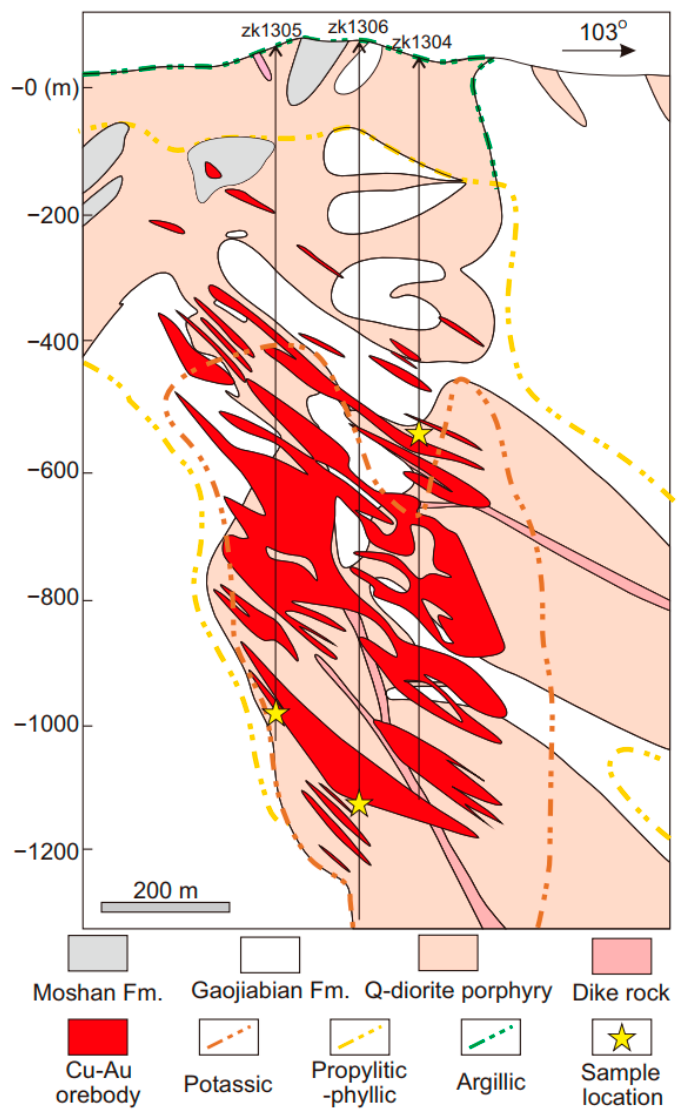
Figure 3. Geological map of the Shaxi porphyry deposit (modified after [45]). Abbreviations: Fm. = Formation.